Question: What does this figure show? Answer in one sentence.
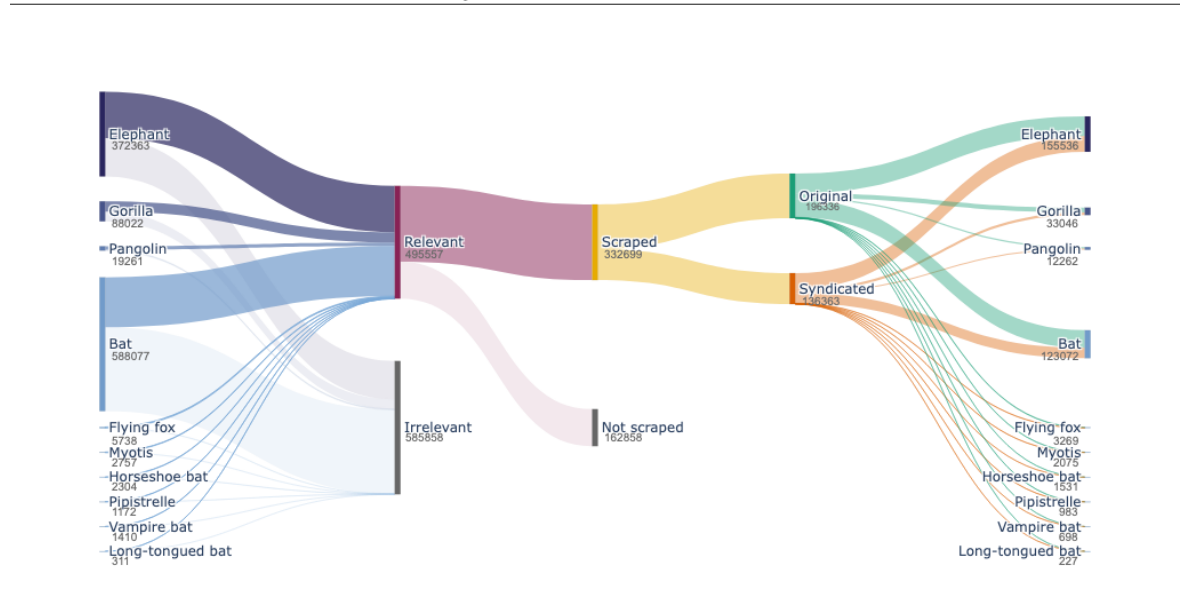
Answer: shows the outcome at each stage of our GDELT data collection pipeline applied to the 10 case study taxa. Raw article counts varied from 588,077 results for “bat” to 311 for “long-tongued bat”. Notably, approximately 54% of articles were predicted to be irrelevant to wildlife, with “bat” (62.6%), “gorilla” (48.4%), “elephant” (45.3%) and “vampire bat” (36.4%) yielding high proportions of unrelated content due to homonymy (e.g. “bat” as a piece of sports equipment), idiomatic expressions (e.g. “elephant in the room”, “800 pound gorilla”, and “off the bat”), and popular culture depictions of these animals. Full-text scraping was attempted for all articles that were predicted to be relevant based on their title, yet about a third were inaccessible due to broken links. We also found that 41% of articles across